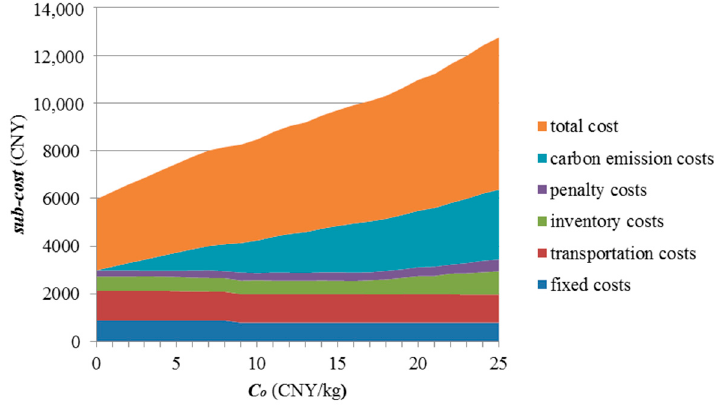
Figure 3. The stacked area chart that shows the changing trends of total cost and each sub-cost as the carbon tax changes.